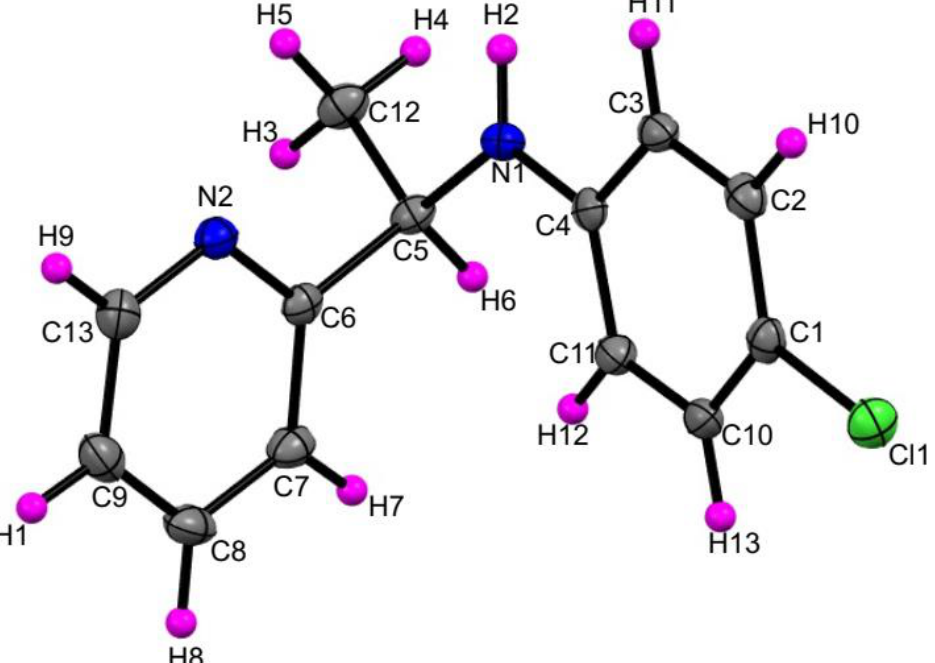
Table 1. Selected geometric parameters for L b .